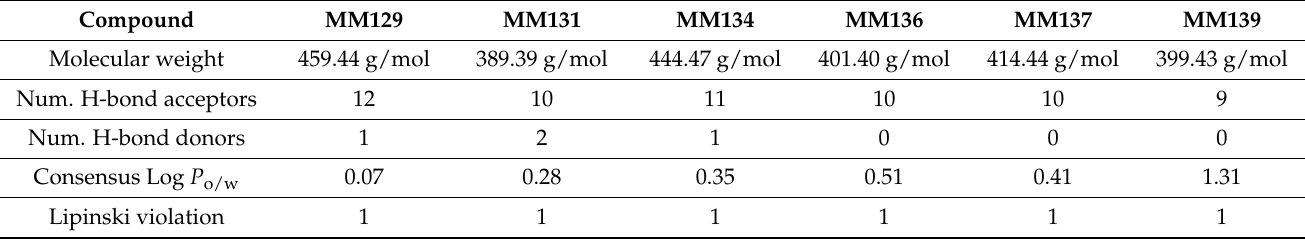
Table 7. Predicted molecular properties related to Lipinski’s rule of